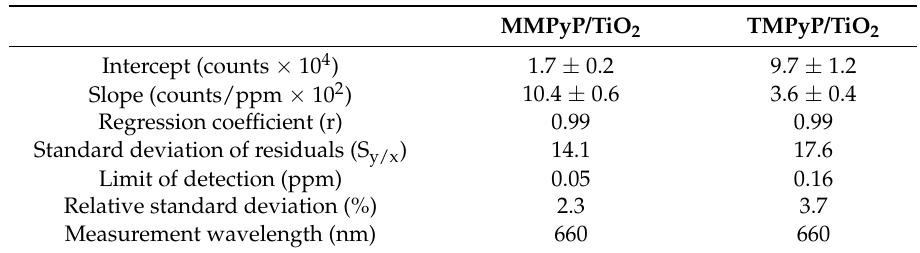
Table 2. Analytical characteristics obtained from the calibration curves of MMPyP/TiO 2 and TMPyP/TiO 2 under ammonia exposure.